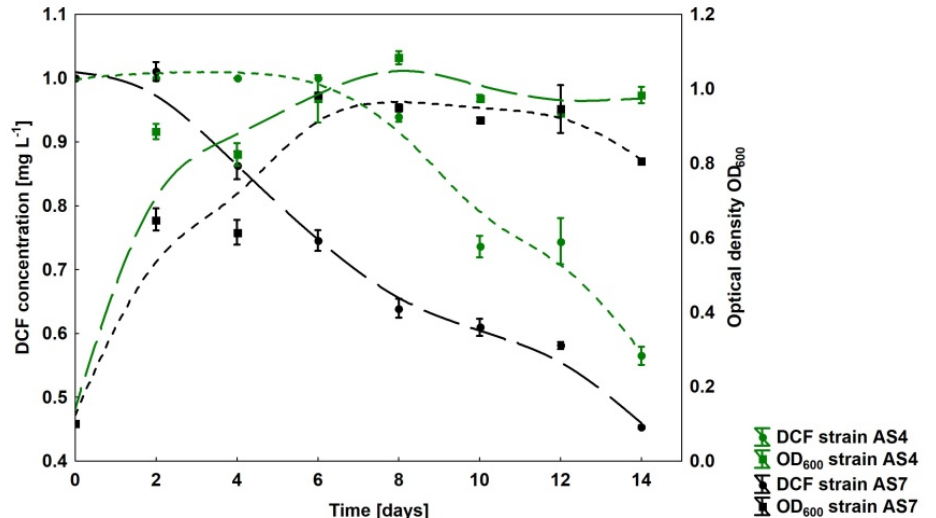
Figure 8. Changes in the optical density (OD 600 ) and degradation of DCF by S. proteamaculans AS4 and R. bruchi AS7 under co-metabolic conditions with glucose (1 g L − 1 ). The data are presented as the mean values of three biological replicates ± standard deviation.